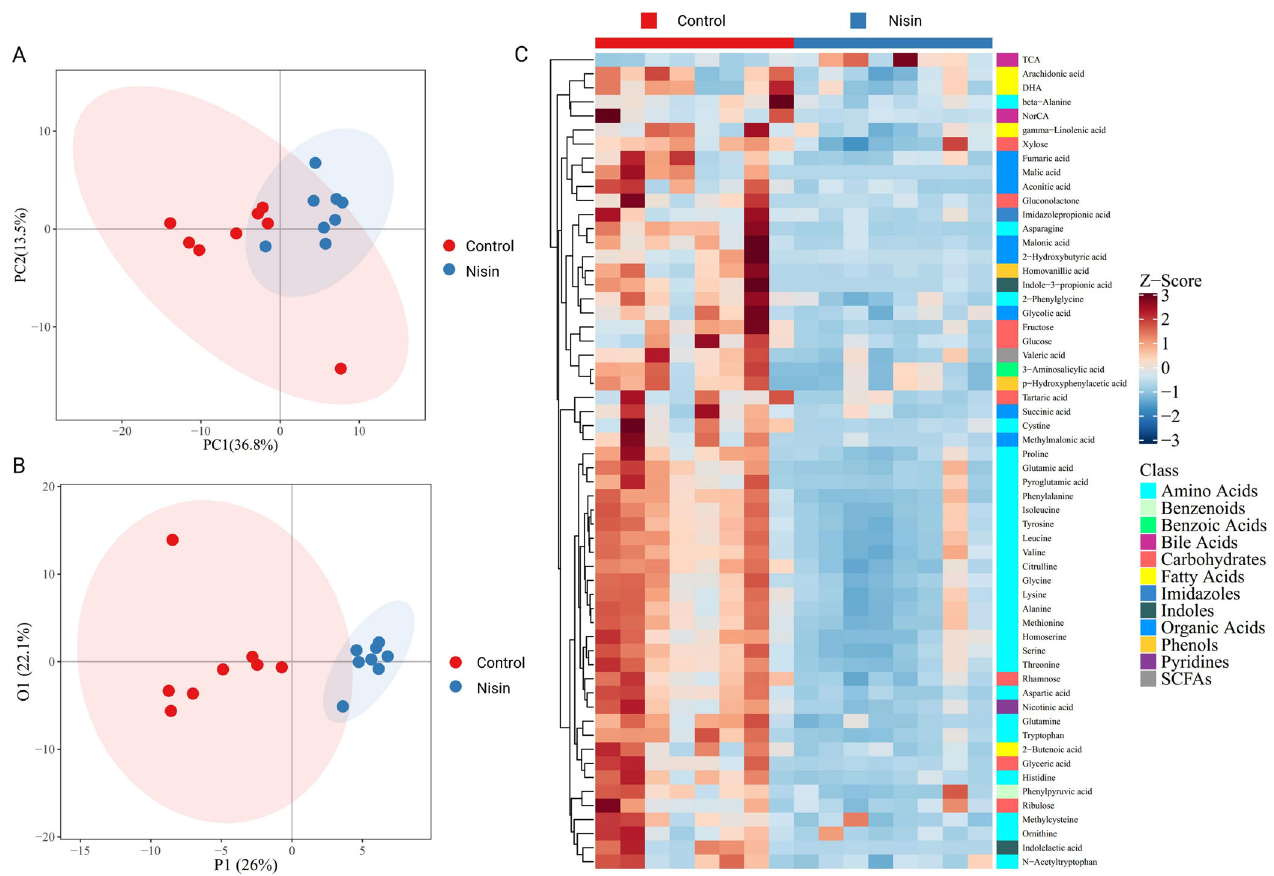
Fig. 4 Effect of nisin on gut microbiota associated metabolism analyzed by targeted metabolomics in feces samples. A , B PCA ( A ) and OPLS-DA ( B ) indicating clear separation between control and nisin-treated samples. C Hierarchical clustering of heatmap displaying the 58 signi fi cantly changed metabolites between two groups. n = 6 per